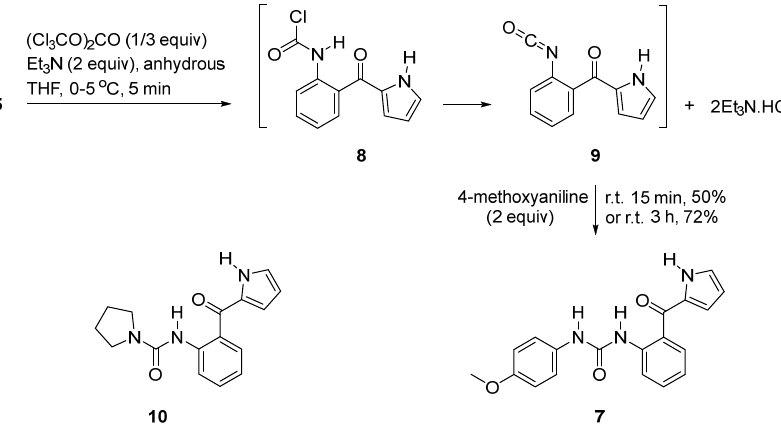
Scheme 1. Synthesis of 1-(2-(1 H -pyrrole-2-carbonyl)phenyl)-3-(4-methoxyphenyl)urea ( 7 ) from aminophenyl pyrrole ( 5 ) via carbamate ( 6 ).